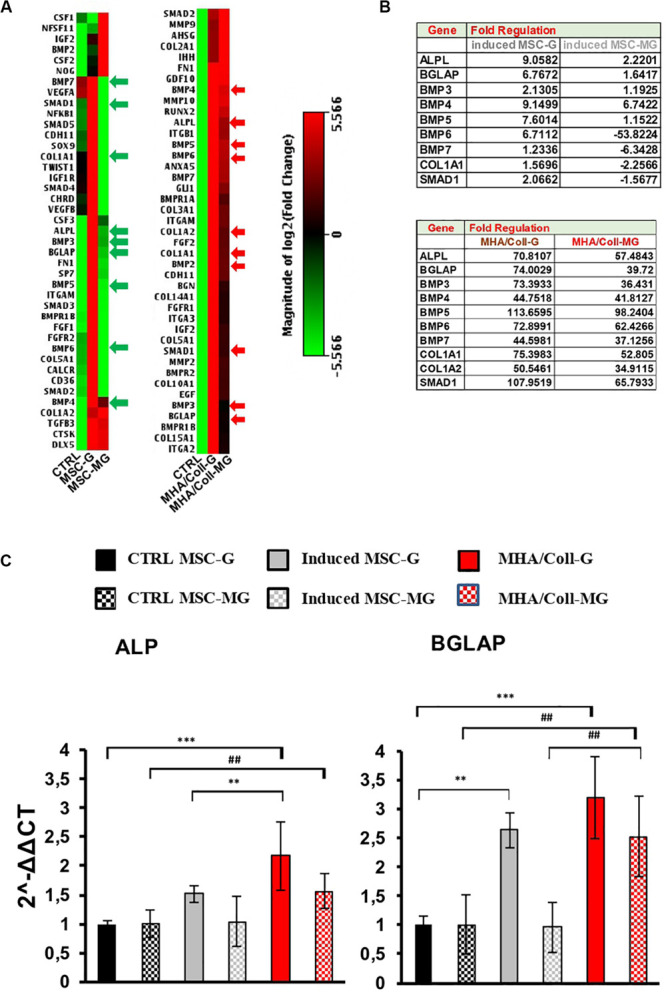
Osteo-differentiation related gene expression array in G and MG conditions. (A) Heat map of 84 osteo-related genes under MG conditions indicating the difference between induced-MSC and 3D MHA/Coll scaffold, showing standardized expression levels of modulated genes for the control, induced-MSC under G and induced-MSC under MG samples, respectively (red: high gene expression; green: low gene expression; black: unmodulated genes). (B) Tables showing the main modulate genes in comparison to the uninduced control in induced-MSC and MHA/Coll under G and MG conditions, respectively. (C) Osteogenic differentiation on MHA/Coll after MG. The main genes involved in osteoblast differentiation were analyzed using Real-Time PCR: alkaline phosphatase (ALP) and osteocalcin (BGLAP). Statistical differences:; **p < 0.01; ***p < 0.001, for G group vs. ctrl G; ##p < 0.01, for MG group vs. ctrl MG (Two-way ANOVA). Bars indicate the compared samples under different conditions.